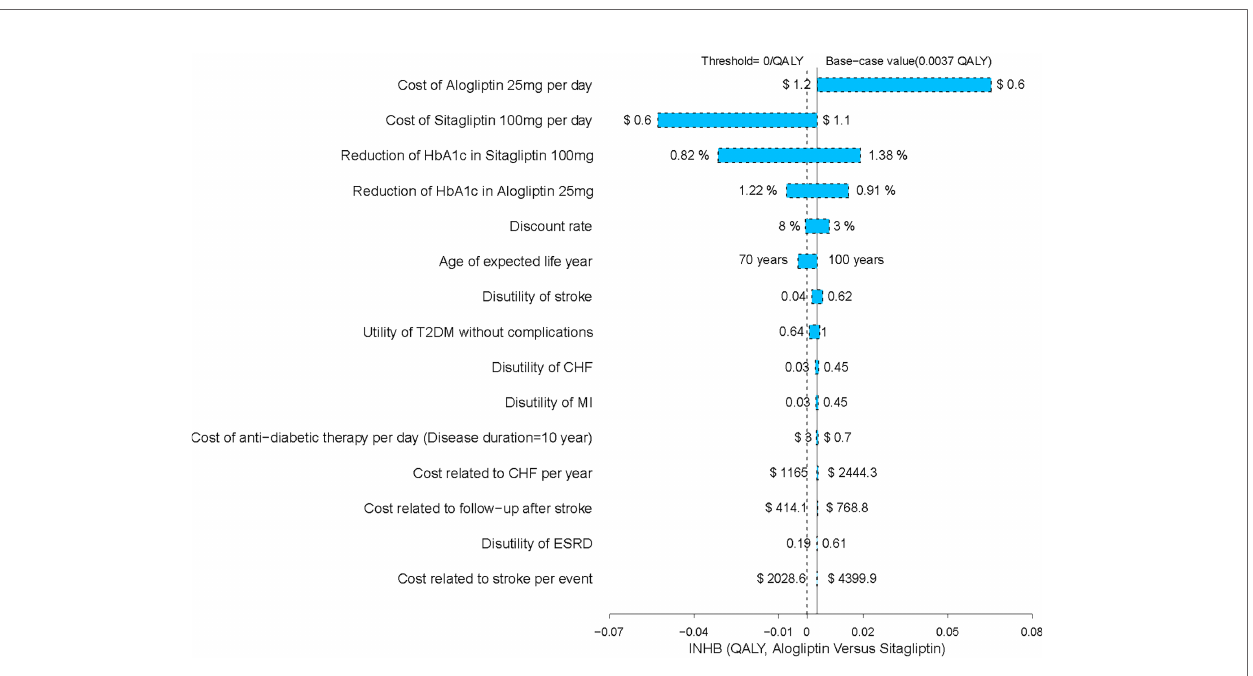
FIGURE 3 | Tornado diagram for alogliptin versus sitagliptin